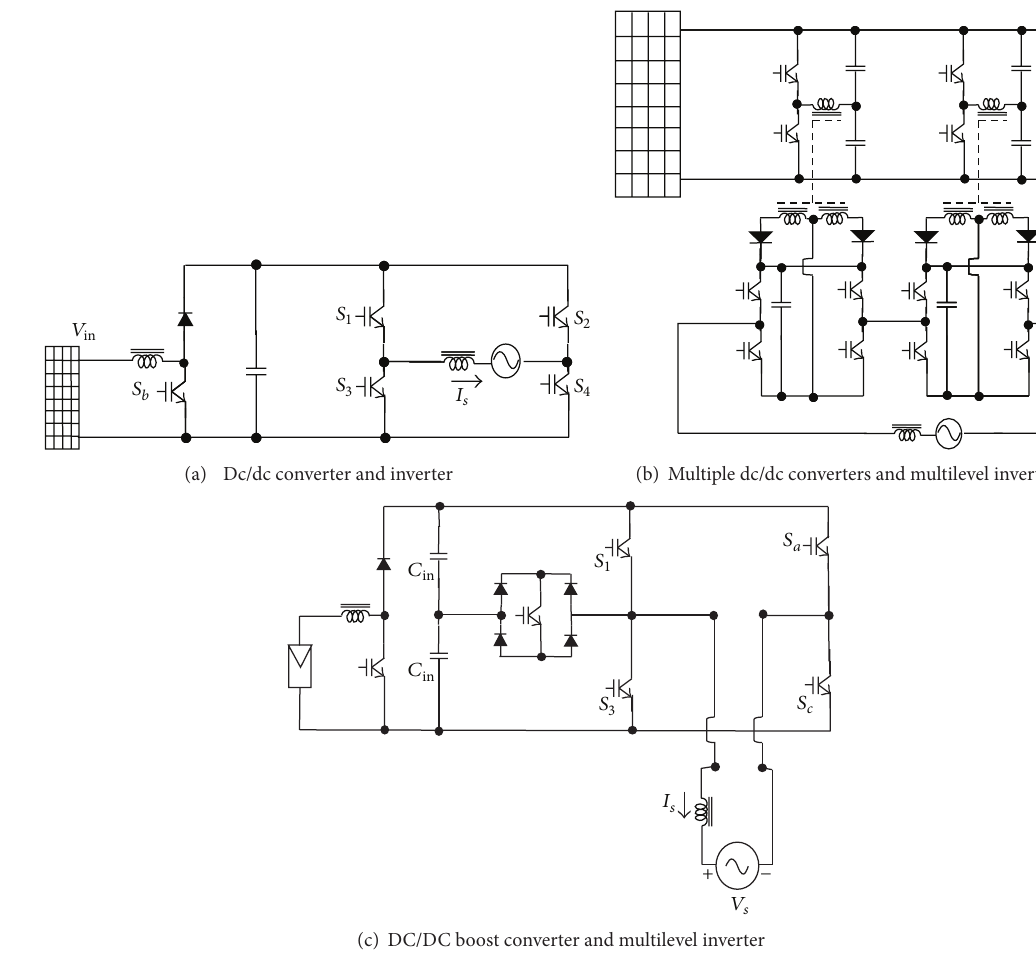
Figure 1: Topologies to inject current to the ac mains based on VSI.